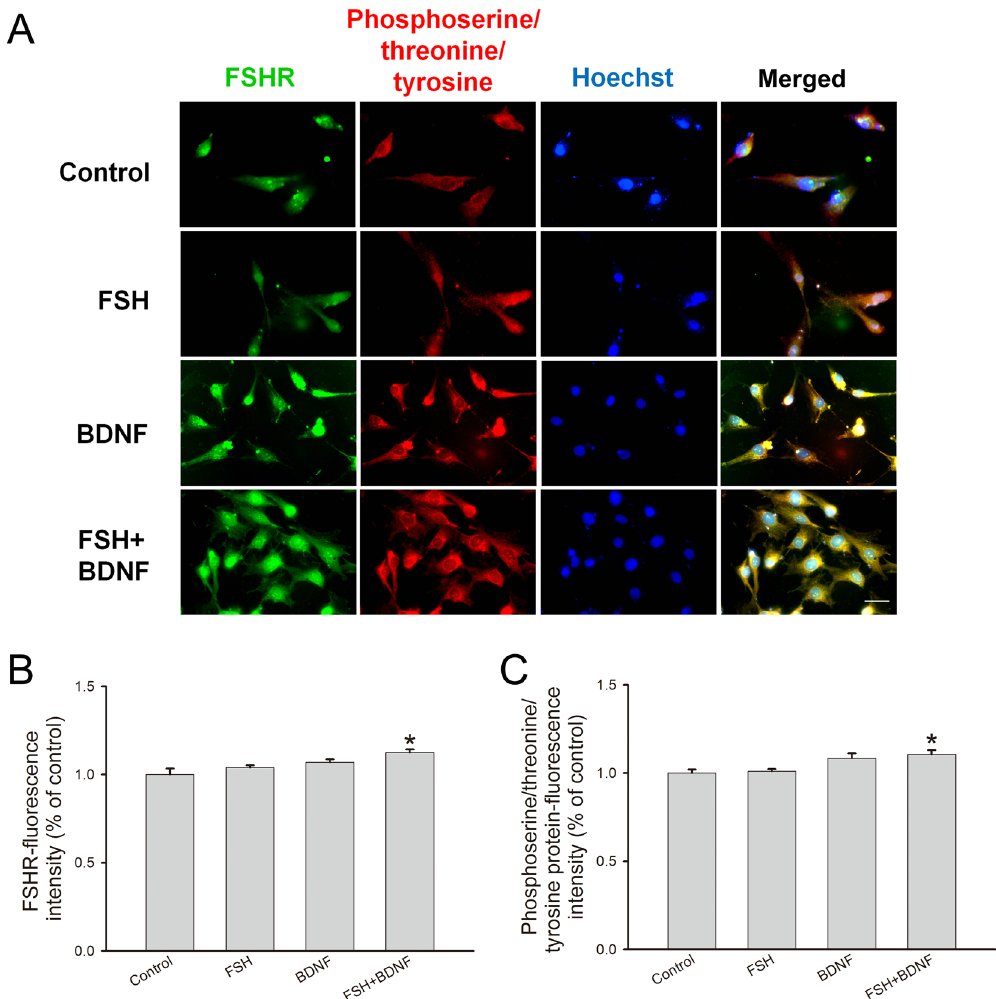
Figure 5. Co-localization of FSH receptor and phosphorylated protein . ( A ) After treatment, cells were fixed and subjected to immunofluorescence. Anti-FSHR antibody was probed with anti-rabbit IgG H&L (FITC) (green); antibody against serine, threonine, and tyrosine phosphorylated proteins was probed with anti-mouse IgG H&L (TRITC) (red). Cells were counterstained with Hoechst (blue). Co-localization of FSHR and serine, threonine, and tyrosine phosphorylated proteins was shown in merged images (yellow). ( B ) Quantification of FSHR staining in control and treated cells. (C) Quantification of phosphorylated staining in control and treated cells. * P < 0.05 versus control group. Scale bar = 500 μ